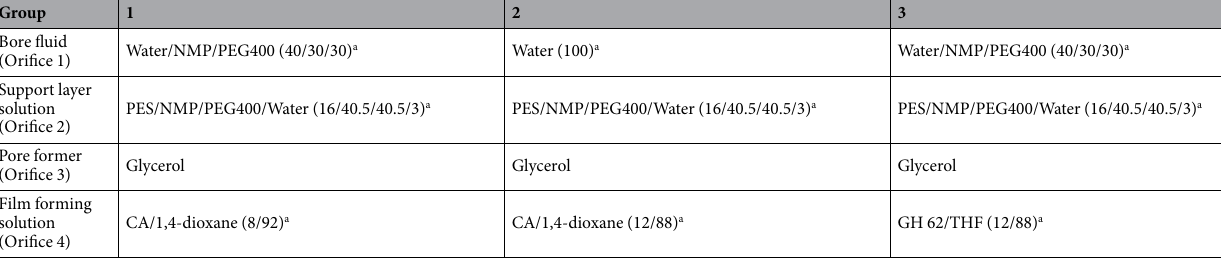
Table 1. Solutions purged through the different orifices of the spinneret. a The ratios of the components in the solutions are expressed in wt%.